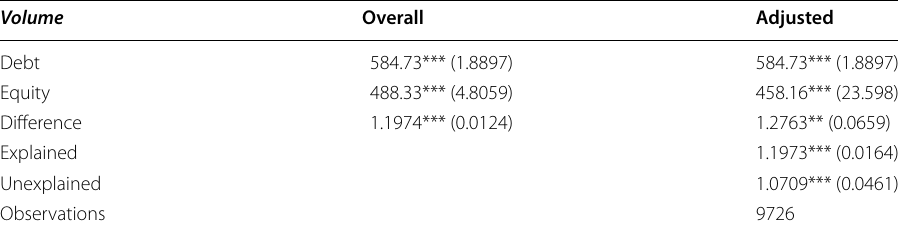
Table 1 Blinder–Oaxaca decomposition of equity and debt issuance applied to a sample of 6834 publicly listed US firms over the sample period starting 2000 until 2018